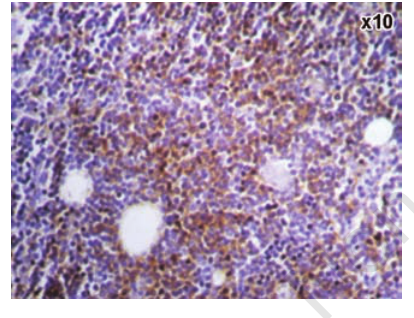
Figure 4. A case of chronic lymphocytic leukemia showing positive CD5.